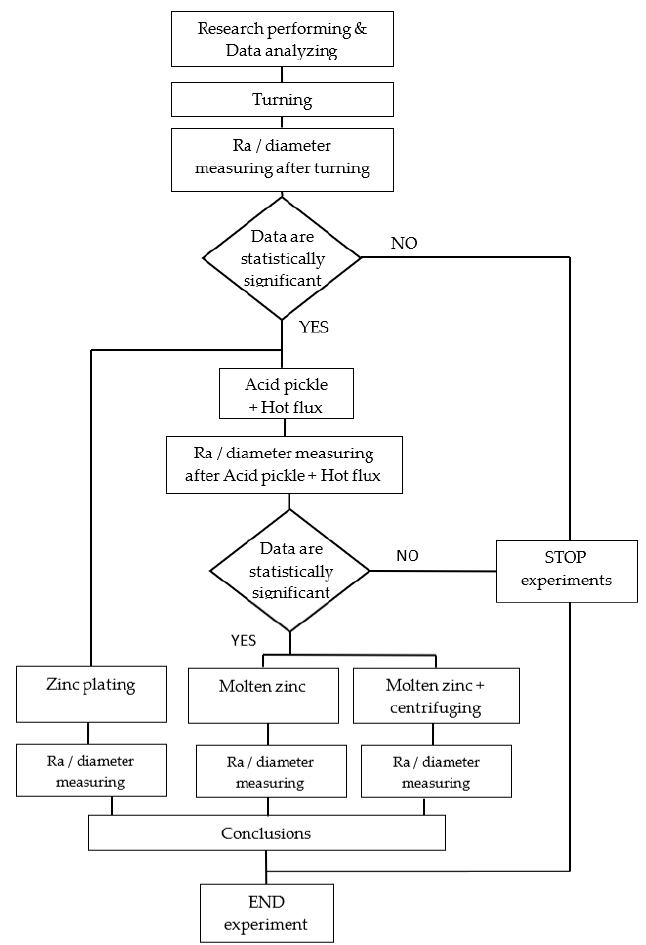
Figure 10. Diagrams for the experiment, measurements, and analysis of the experimental data.